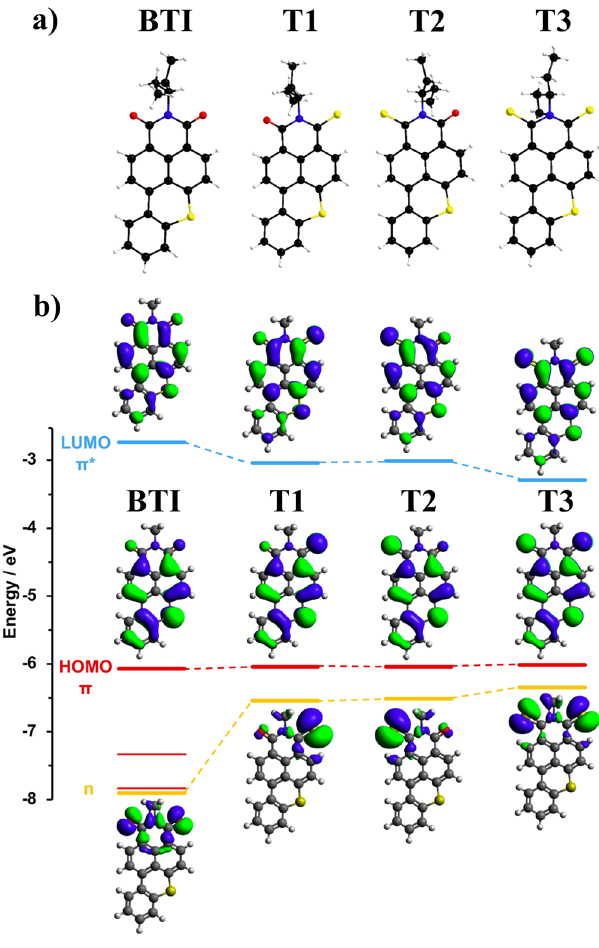
Fig. 2 X-ray structures and computed data for T1-T3. a Molecular structures of BTI and the related thionated compounds ( T1 – T3 ) con fi rmed by X-ray diffraction on single crystals (S: yellow, O: red, C: black, H: gray, N: blue). b DFT computed molecular orbitals levels (PBE0/6-311 + G(d,p)/ dichloromethane PCM). Occupied π orbitals, occupied n orbitals and unoccupied π * orbitals are in red, orange, and blue, respectively. Orbital iso-surfaces are drawn with an iso-contour of 0.02 a.u.